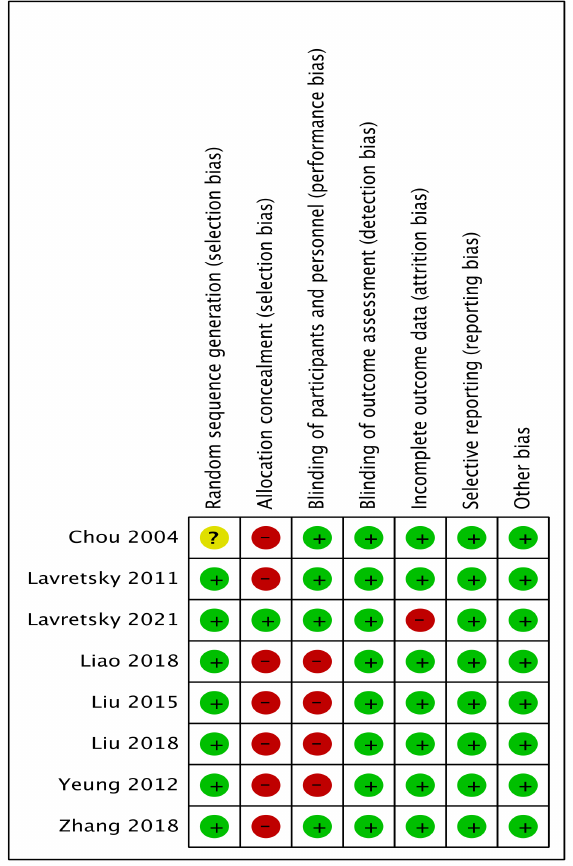
Figure 2. Risk of bias graph, showing the review authors’ judgements of each risk of bias item presented as percentages across all included studies.